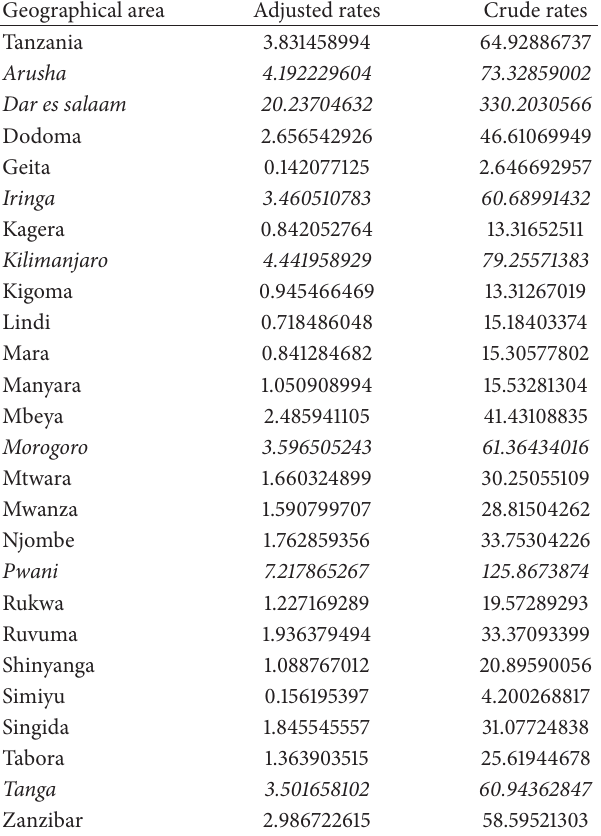
Table 2: Age-standardized incidence rates per 100,000 (world stan- dard) in Tanzania and different administrative regions of Tanzania.